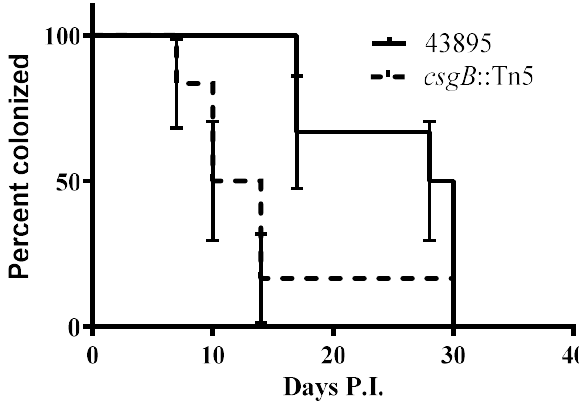
Figure 7. Curli production enhances persistence of O157 in cattle. Two groups of six cattle were challenged with WT 43895 and the isogenic curli-negative mutant csgB -Tn5 using a single rectal application of 10 CFU of bacteria. Rectal swab samples from each animal was taken twice a week and cultured for E. coli O157 for 30 days. Percent survival indicated the percent of the cattle that were E. coli O157 culture positive. Survival time (duration of carriage) was defined as the number of days animals were cultured positive with E. coli O157 and the p < 0.05 was calculated by the log-rank (Mantel–Cox) test.